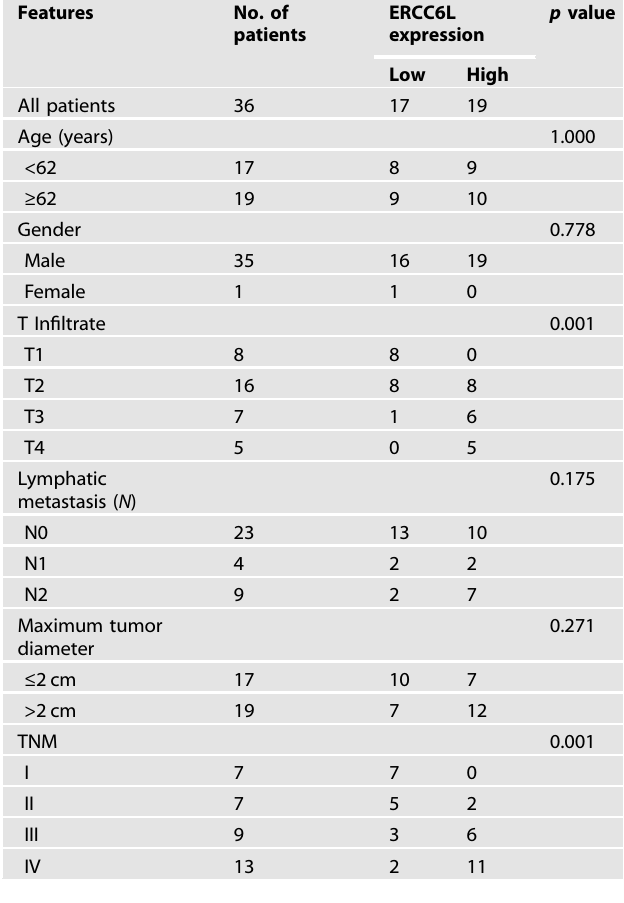
Table 2. Relationship between ERCC6L expression and tumor characteristics in patients with laryngocarcinoma.